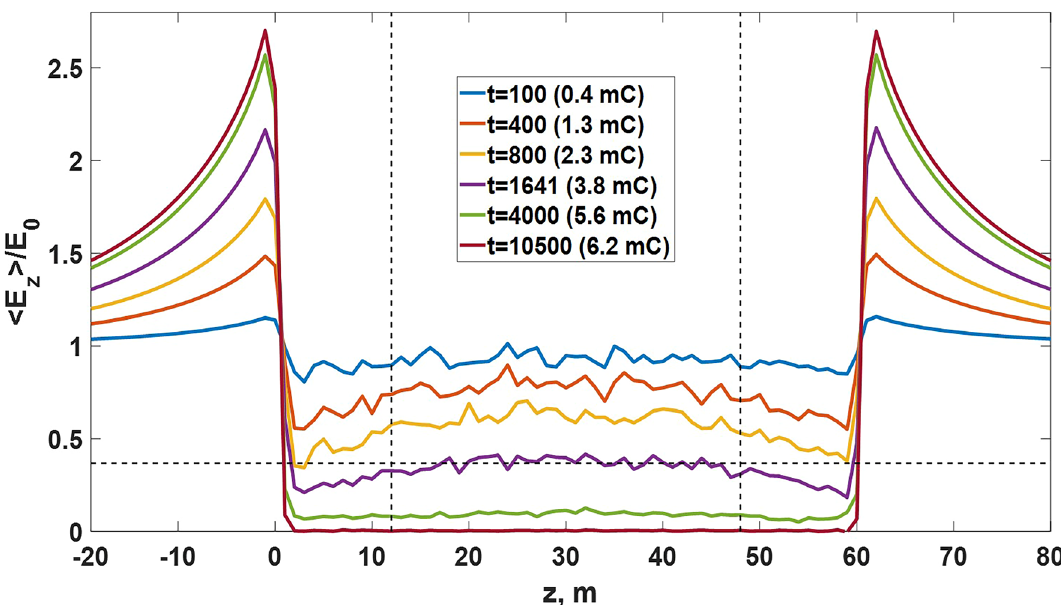
Figure 8. Distribution curves of normalized electric field projections E z averaged over x and y axes inside z 60 m) and outside ( z < 0 m and z > 60 m) the simulation domain at different moments of time ( 0 ≤ ≤ (expressed in model time steps) for the same case as in Fig. 7. Horizontal dotted line indicates the level of e − 1 , 48 m used in Eq. (7) to find an averaged field E eff 12 m and z u while the vertical ones denote applicates z b = = inside the middle part of the simulation domain. For each electric field distribution, the total charge divided by relay charge transport is given in the